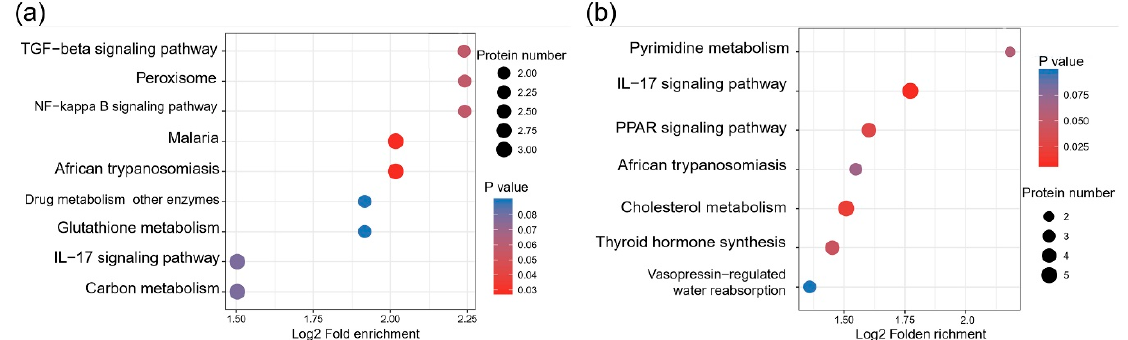
Figure 3. ( a ) Kyoto Encyclopedia of Genes and Genomes (KEGG) pathway enrichment of PP vs CC differential proteins. ( b ) KEGG pathway enrichment of PC vs. CC differential proteins. Note: Vertical axis of bubble chart is functional classification or pathway, enrichment test by Fisher's exact test. Table 2. KEGG pathway enrichment of PP vs CC differential proteins.